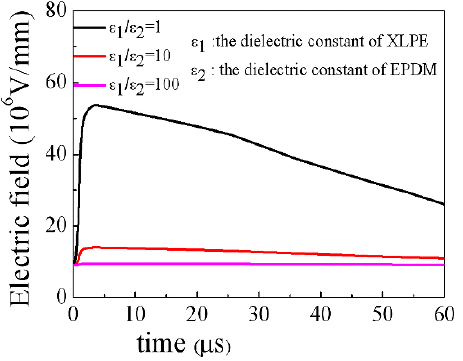
Figure 15. Variation of the electric field strength with different dielectric constants in the lightning impulse process.